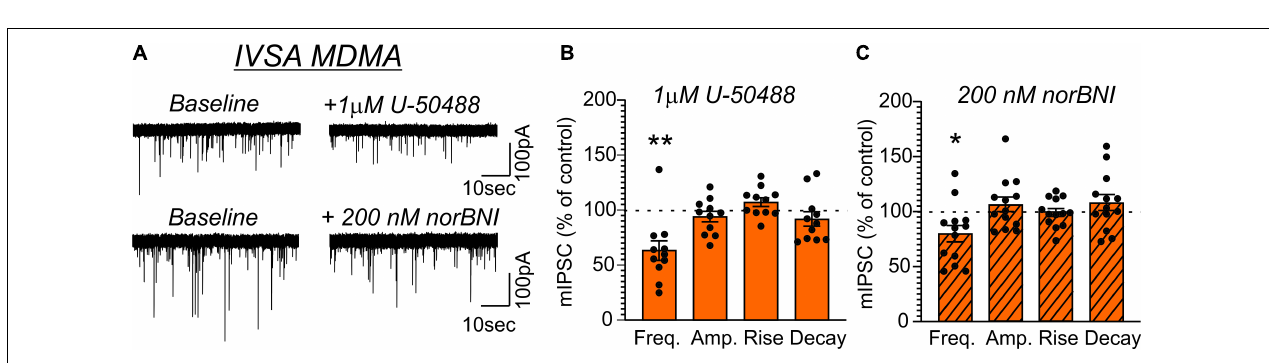
FIGURE 7 | (A) Representative mIPSCs from CeA neurons during control and during superfusion with the KOR-agonist U-50488 (1 µ M, upper panel) or the KOR-antagonist norBNI (200 nM, lower panel) are shown. Bars represent means ± S.E.M of the normalized effects of (B) U-50488 or (C) norBNI on mIPSC characteristics. Statistically significant differences to baseline control were calculated using a one-sample t -test. (*) = P < 0.05, (**) = P < 0.01.